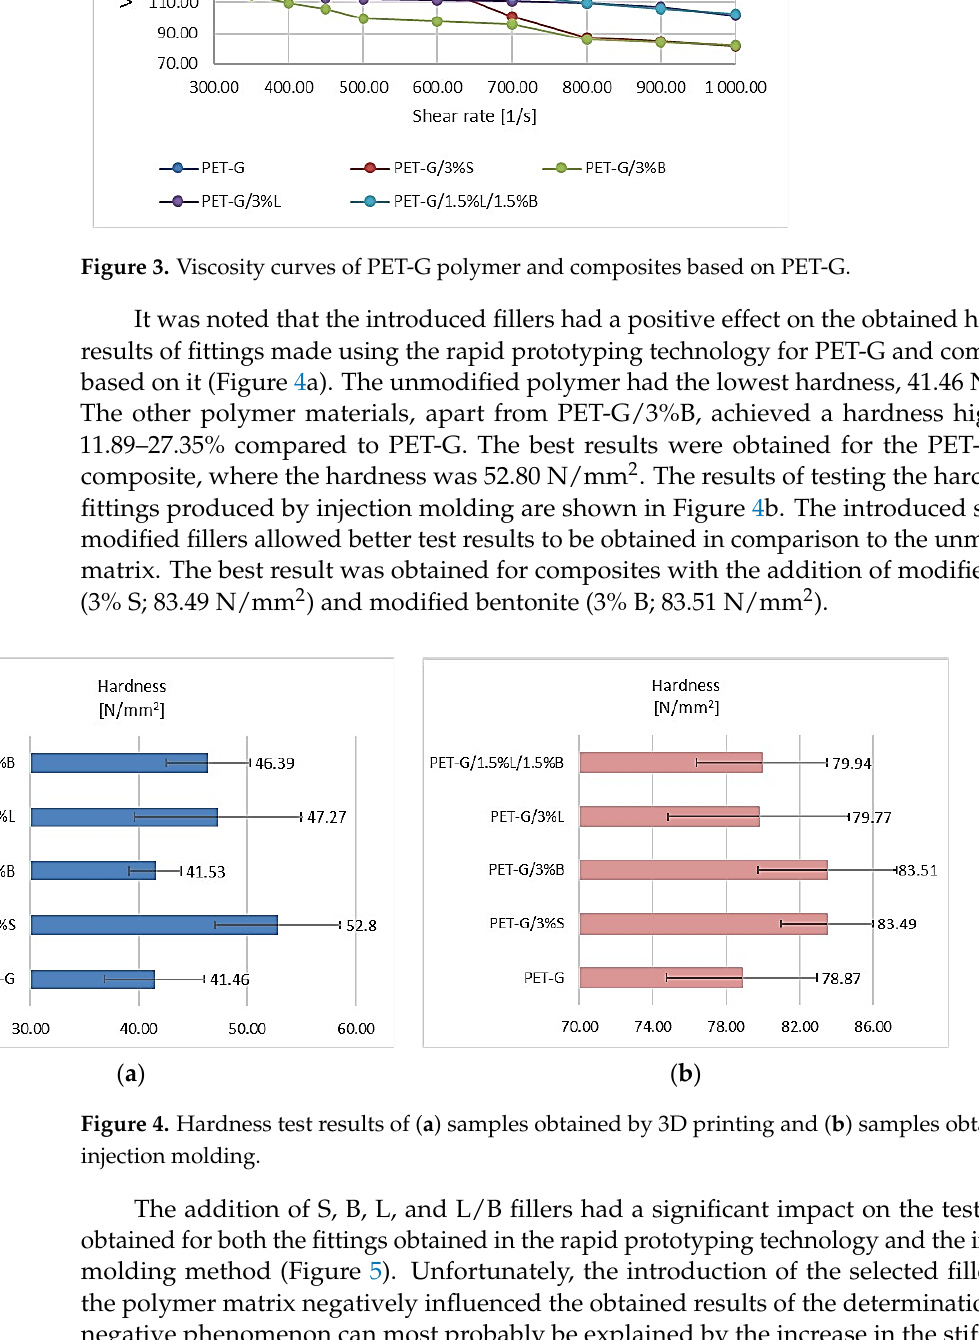
( b ) Figure 5. Impact strength test results of ( a ) samples obtained by 3D printing and ( b ) samples obtained by injection molding. In the case of composites obtained by 3D printing, after introducing fillers B and the hybrid L/B system, the Young ’ s modulus was improved. For composites containing 3%S and 3%L, Young ’ s modulus was slightly lower. On the other hand, when analyzing the results of Young ’ s modulus for moldings produced by injection molding presented in Table 4, a beneficial effect of the addition of these fillers on the mechanical properties of the obtained composites was noticed. In each case, the Young ’ s modulus for the